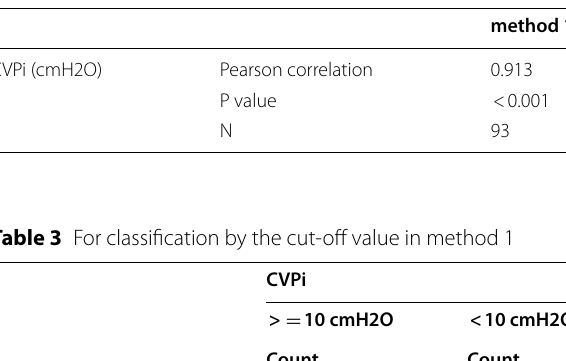
a b Fig. 7 Ultrasound images for a 56 years old male patient ( a ) a longitudinal ultrasound image for the collapsing point of the IJV (vertical white arrow) (method 1) where the IJV was collapsed all through its neck course with the collapsing point was almost detected at the level of the sternoclavicular joint ( b ) transverse ultrasound image demonstrating the cross‑sectional areas (marked as dotted yellow lines by manual tracers) of the IJV ( 0.12 cm 2 ) and the CCA area ( 0.43 cm 2 ) and the ratio ( 0.27) (method 2). The Invasive CVP measurement (by the catheter) was 2 cmH20 = = = Table 2 Showing the correlation between (CVPni) and CVPi in Table 5 Showing the correlation between IJV/CCA area ratio method 1